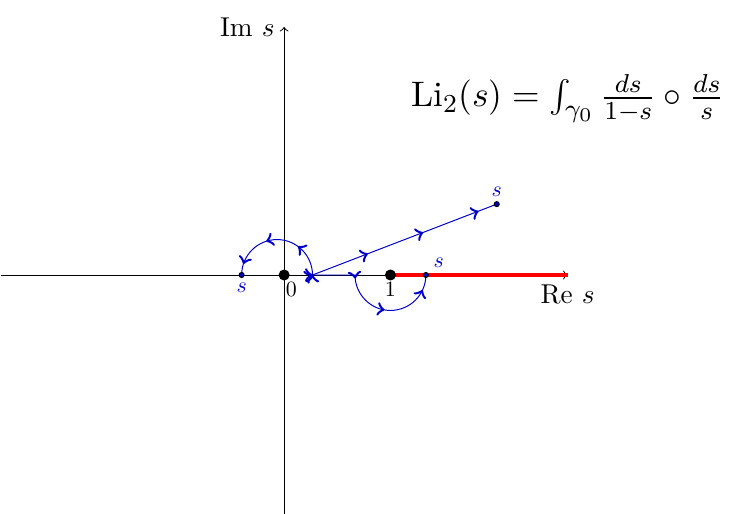
Figure 3 . Li 2 ( s ) has branch points at s = 0 and s = 1 . The principal branch of Li 2 ( s ) has a branch cut on the real line from s = 1 to + ∞ . The standard contour γ 0 in the analytic integral definition of Li 2 ( s ) begins at a basepoint at s = ε > 0 and proceeds in a straight line to s , diverting in a counterclockwise path around the branch points when